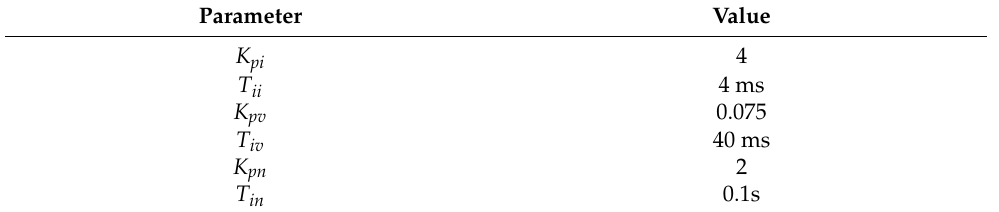
Table 2. Parameters of PI